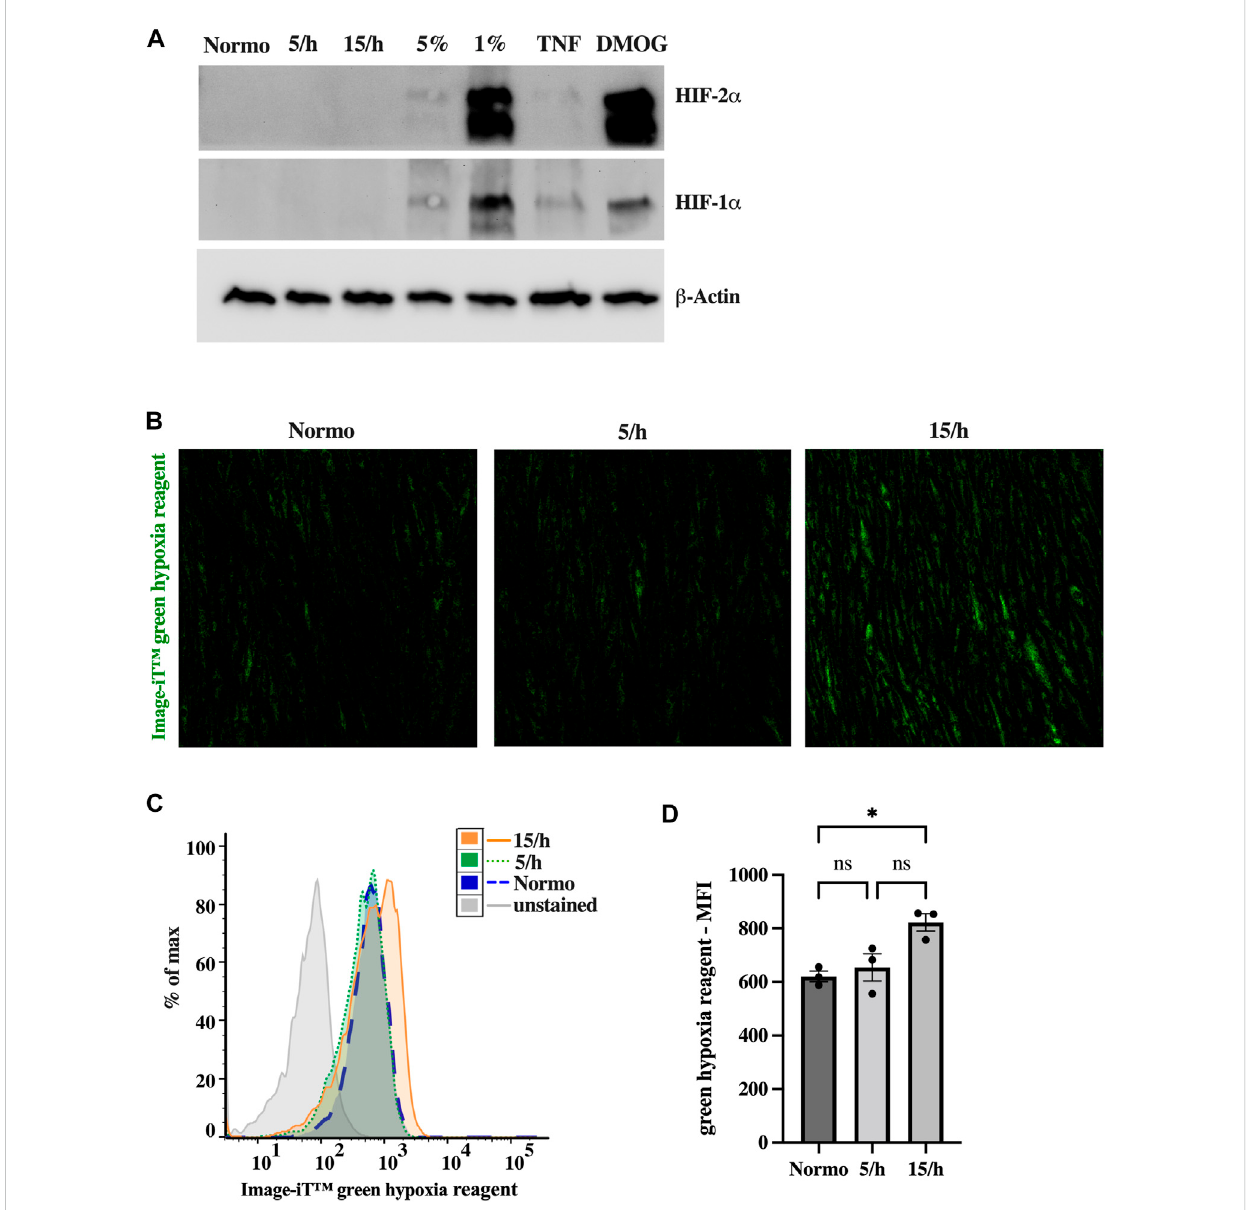
FIGURE 2 Intermittent low grade hypoxia (pcO 2 35 mmHg 15 cycles per hour, for 4 h) does not trigger HIF1 α and HIF2 α stabilization, but activates sensitive hypoxic molecular probe. After 48 hof 15 dyn/cm 2 shear stress endothelial cells were treated with 5 or 15 cycles per hour of intermittenthypoxiafor 4 h. WesternBlotsofHIF1 α andHIF2 α (A) didnotshowanyexpressioninendothelialcelllysatesafterintermittenthypoxia.Incontrast,5%,andinparticular1% of constant hypoxia or the treatment with Dimethyloxalylglycine (DMOG, 1 mM), an inhibitor for HIF prolylhydroxylases, for 4 h did stabilize HIF1 α and HIF2 α . In fl ammatory activation (TNF 25 ng/mL) resulted in slight HIF expression. However, using a sensitive marker of low dose hypoxia (Image-iT ™ green hypoxia reagent), we detected a signi fi cant increase in staining following 15 hypoxic cycles per hour in confocal microscopy (B) . Upon completion of confocal images, HUVECs were detached and subjected to detailed fl uorescence analysis on a single cell level by fl ow cytometry. (C) shows a representative histogram of one experiment depicting the mean fl uorescence intensity (MFI) of Image-iT ™ green hypoxia reagent in all experimental groups. The data of three independent experiments are summarized in the bar graph of (D) . Shown are means ± SEM. n = 3 – 6, * p <